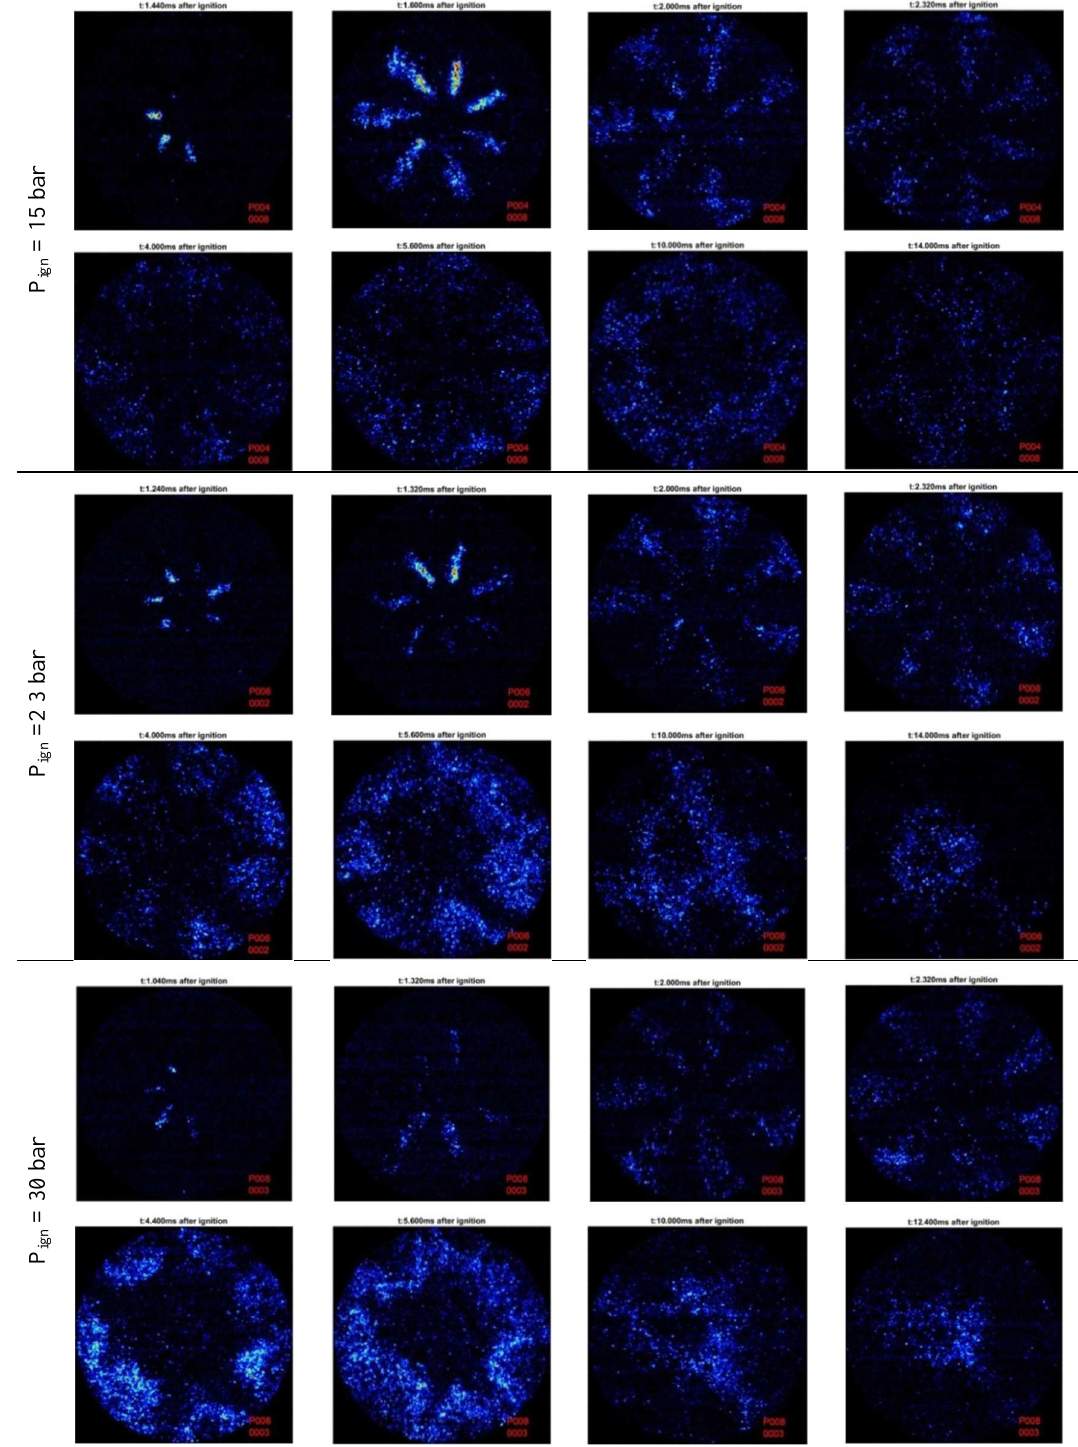
Fig. 3. OH* chemiluminescence images, showing the prechamber jets and the combustion evolution in the main chamber in cases when ignition occurred at 15 bar (first two lines), 23 bar (middle two lines) and 30 bar (last two